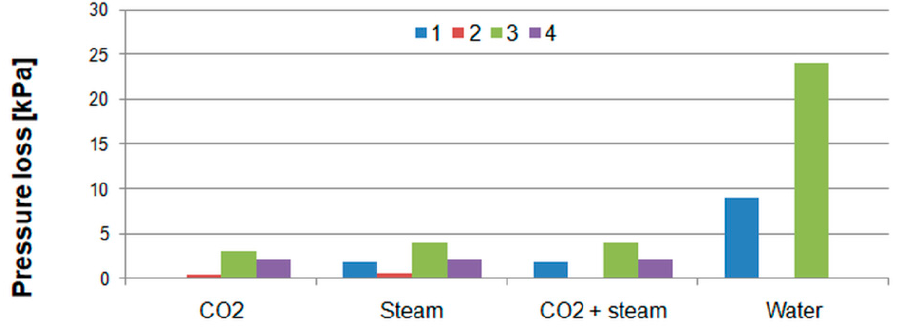
Figure 3. Maximum pressure loss at rated flow.